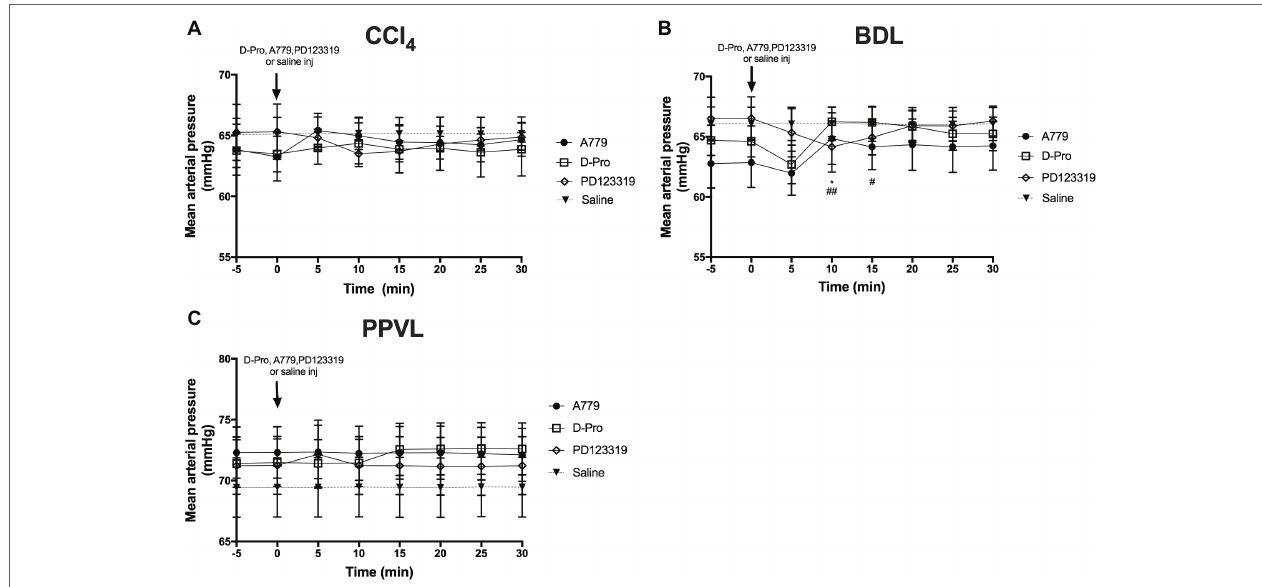
FIGURE 4 | Changes in mean arterial pressure (MAP) with intravenous bolus injections of either MasR blocker A779 (10 μ g/kg), MrgD blocker D-Pro (10 μ g/kg) or AT2R blocker PD123319 (1 mg/kg) in CCl 4 (A) BDL (B) , and PPVL (C) models. Saline injection served as the control. Each time point represents the mean ± SEM profile from six to seven rats per treatment group. * p < 0.05 baseline vs. A779; ## p < 0.01, # p < 0.05, baseline vs.